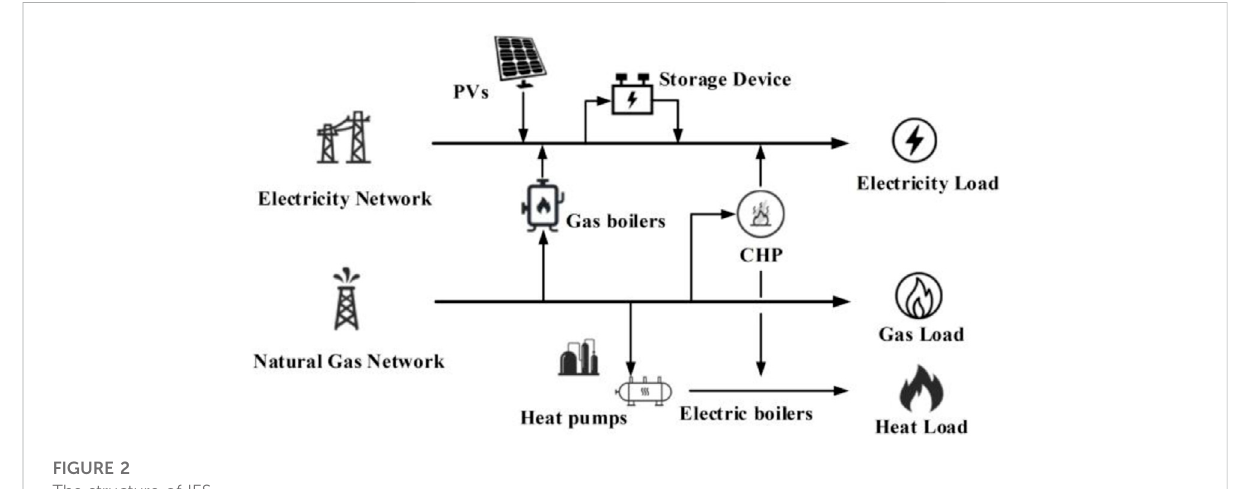
FIGURE 2 The structure of IES.